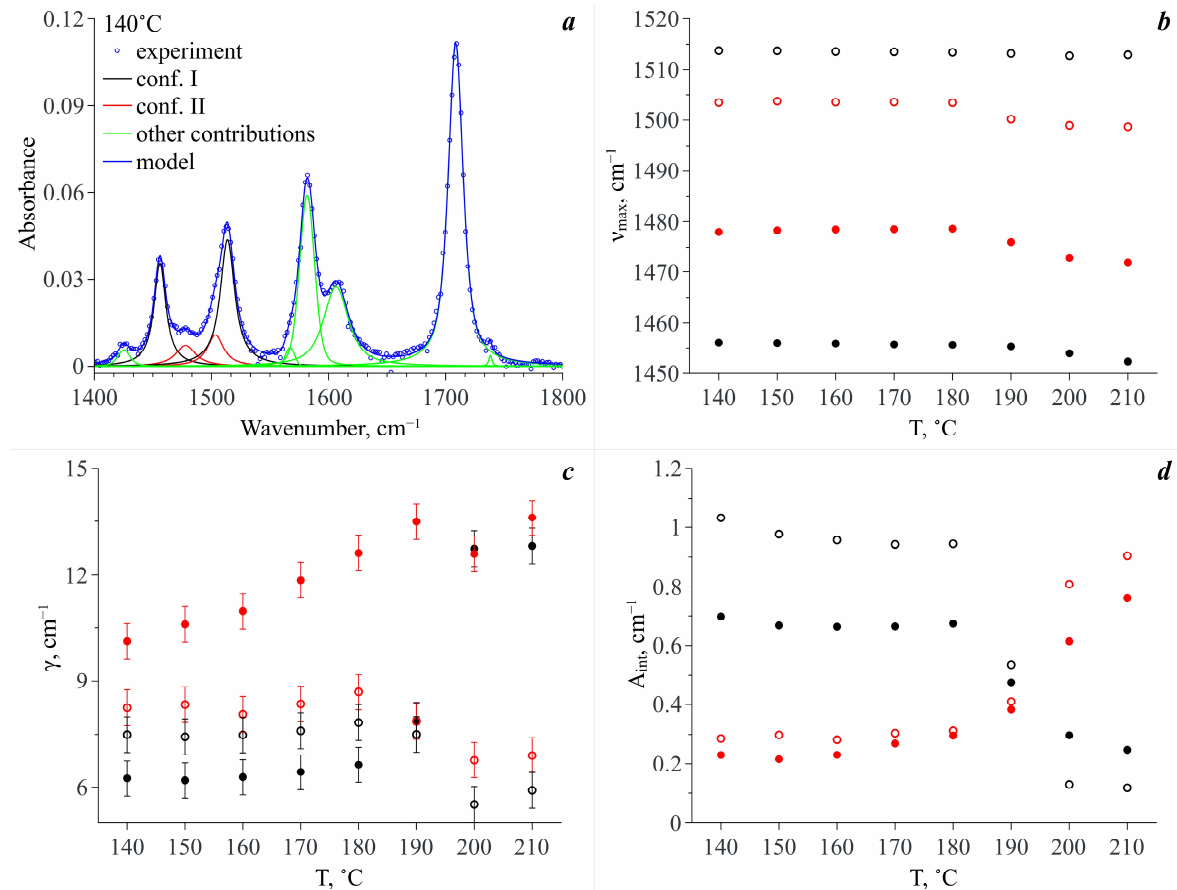
Figure 9. ( a ) An example of the experimental spectrum deconvolution for the temperature of 140 °C. Temperature dependences of: ( b ) the maximum positions of the spectral profiles ( ν max ); ( c ) dispersions of the spectral profiles ( γ ); ( d ) integral intensities of the spectral profiles ( A int ). Hereinafter the black circles correspond to MA Conf. I and the red circles denote MA Conf. II; the solid circles correspond to the spectral bands, which are attributed to the complex vibrations of the aromatic system and the open circles denote the spectral bands assigned to the N–H group rocking vibrations.